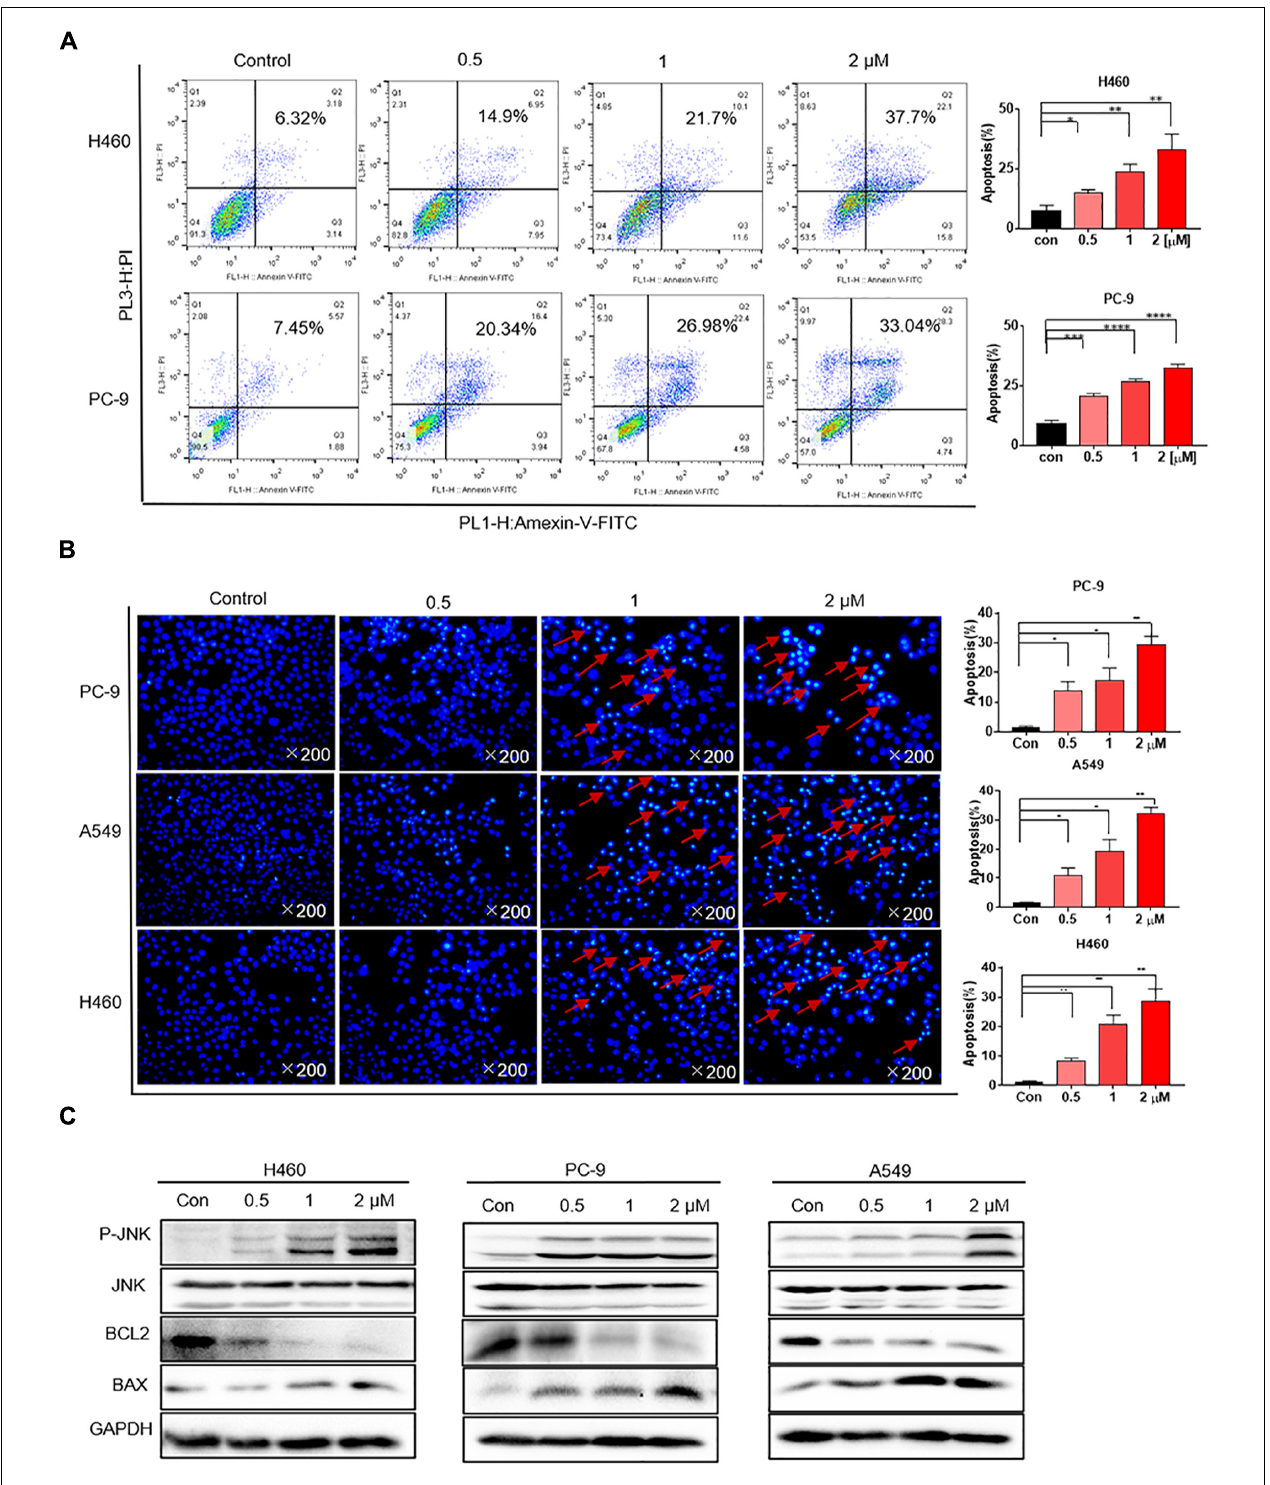
FIGURE 2 | Flubendazole induced apoptosis in human lung cancer cells. (A) Cell apoptosis assays revealed the number of cells stained under positive Annexin V–PI when flubendazole treatment process was achieved. (B) Representative Hoechst 33342 staining shows the apoptotic morphology features pertaining to PC-9, H460, and A549 cells. Red arrows indicate apoptotic bodies. (C) Typical blots indicating the expression states of JNK, BCL-2, and BAX in human lung carcinoma cells. Images shown are representative of three separate experiments (* P < 0.05, ** P < 0.01, *** P < 0.001, **** P < 0.0001).